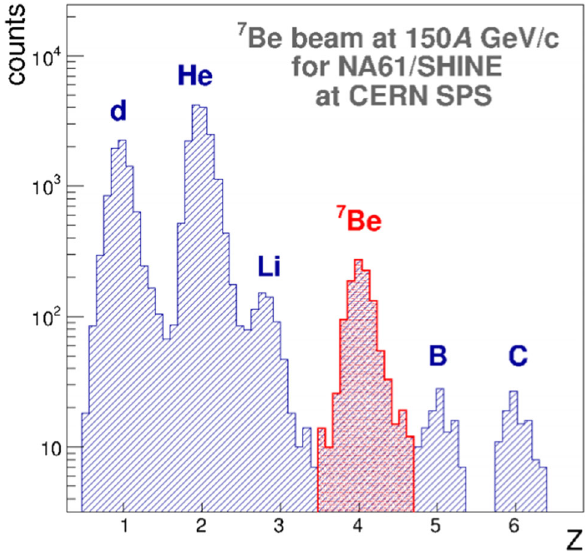
Fig. 3 Charge of the beam particles measured by the Z detector